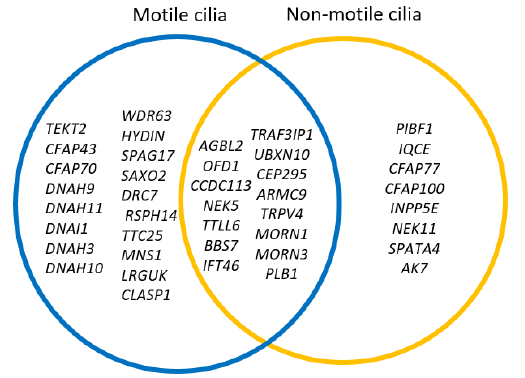
Figure 3. Summary of genetic anomalies found in pediatric patients with TGA. Genetic defects could be observed in the motile and non-motile cilia genes. DNAH3 and MORN3 had been associated with cilia function, although no cilia description of deletion had been reported in models.